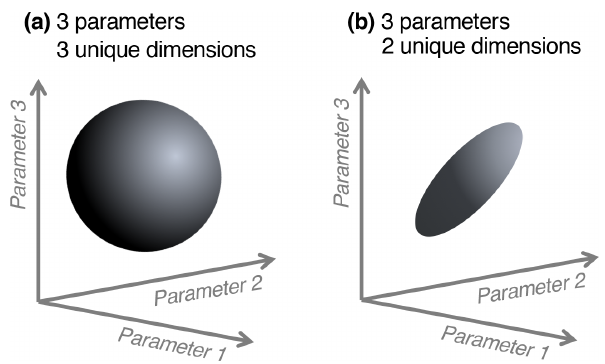
Figure 1. Conceptual diagram of effective complexity in three- parameter space. A sphere (a) has three unique dimensions span- ning the three axes of variability (analogous to a larger solution space for a given model). In the region defined by the same three axes, a disc (b) has only two unique dimensions (analogous to a smaller solution space, perhaps due to two parameters being highly